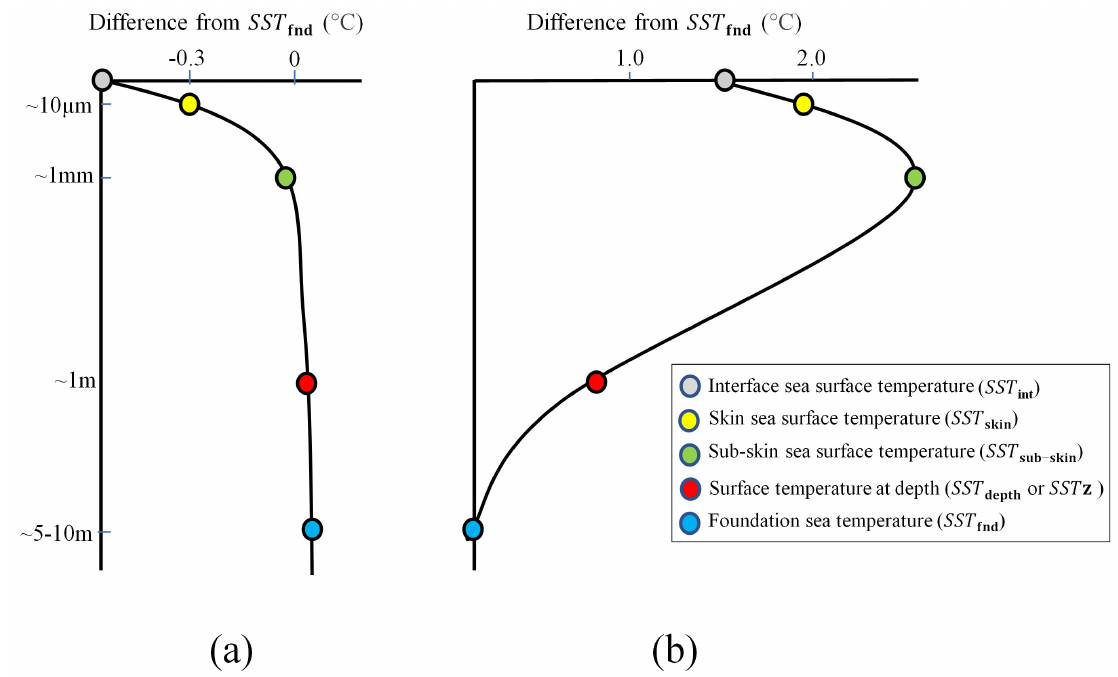
Figure 4. Near-surface oceanic temperature profiles for different types of SSTs at ( a ) nighttime and ( b ) daytime (adopted from the Group for High Resolution Sea Surface Temperature (GHRSST)).